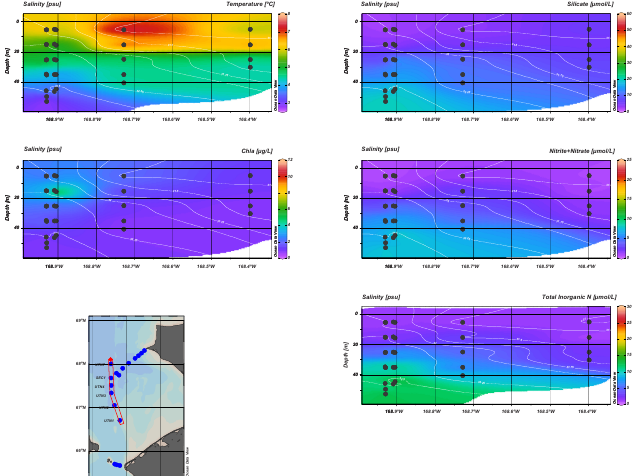
Figure 7. Distributions of water column properties on a southeast to northwest transect of the UTN stations that are part of DBO 3 from the July 2018 Sir Wilfrid Laurier cruise. Salinities are shown as white isolines and colors correspond to nutrients matching the color bars to the right.